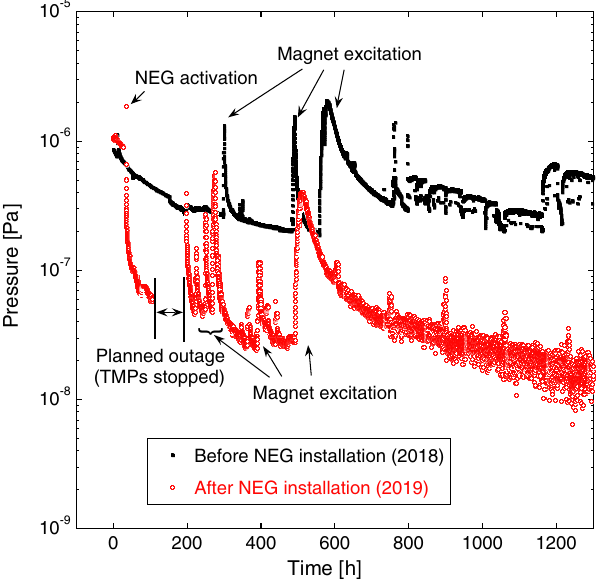
FIG. 30. Pumping curve measured by the EXG in C24 of the third arc section before and after NEG installation. The origin of the horizontal axis is the time after one day of pumping by the TMPs.